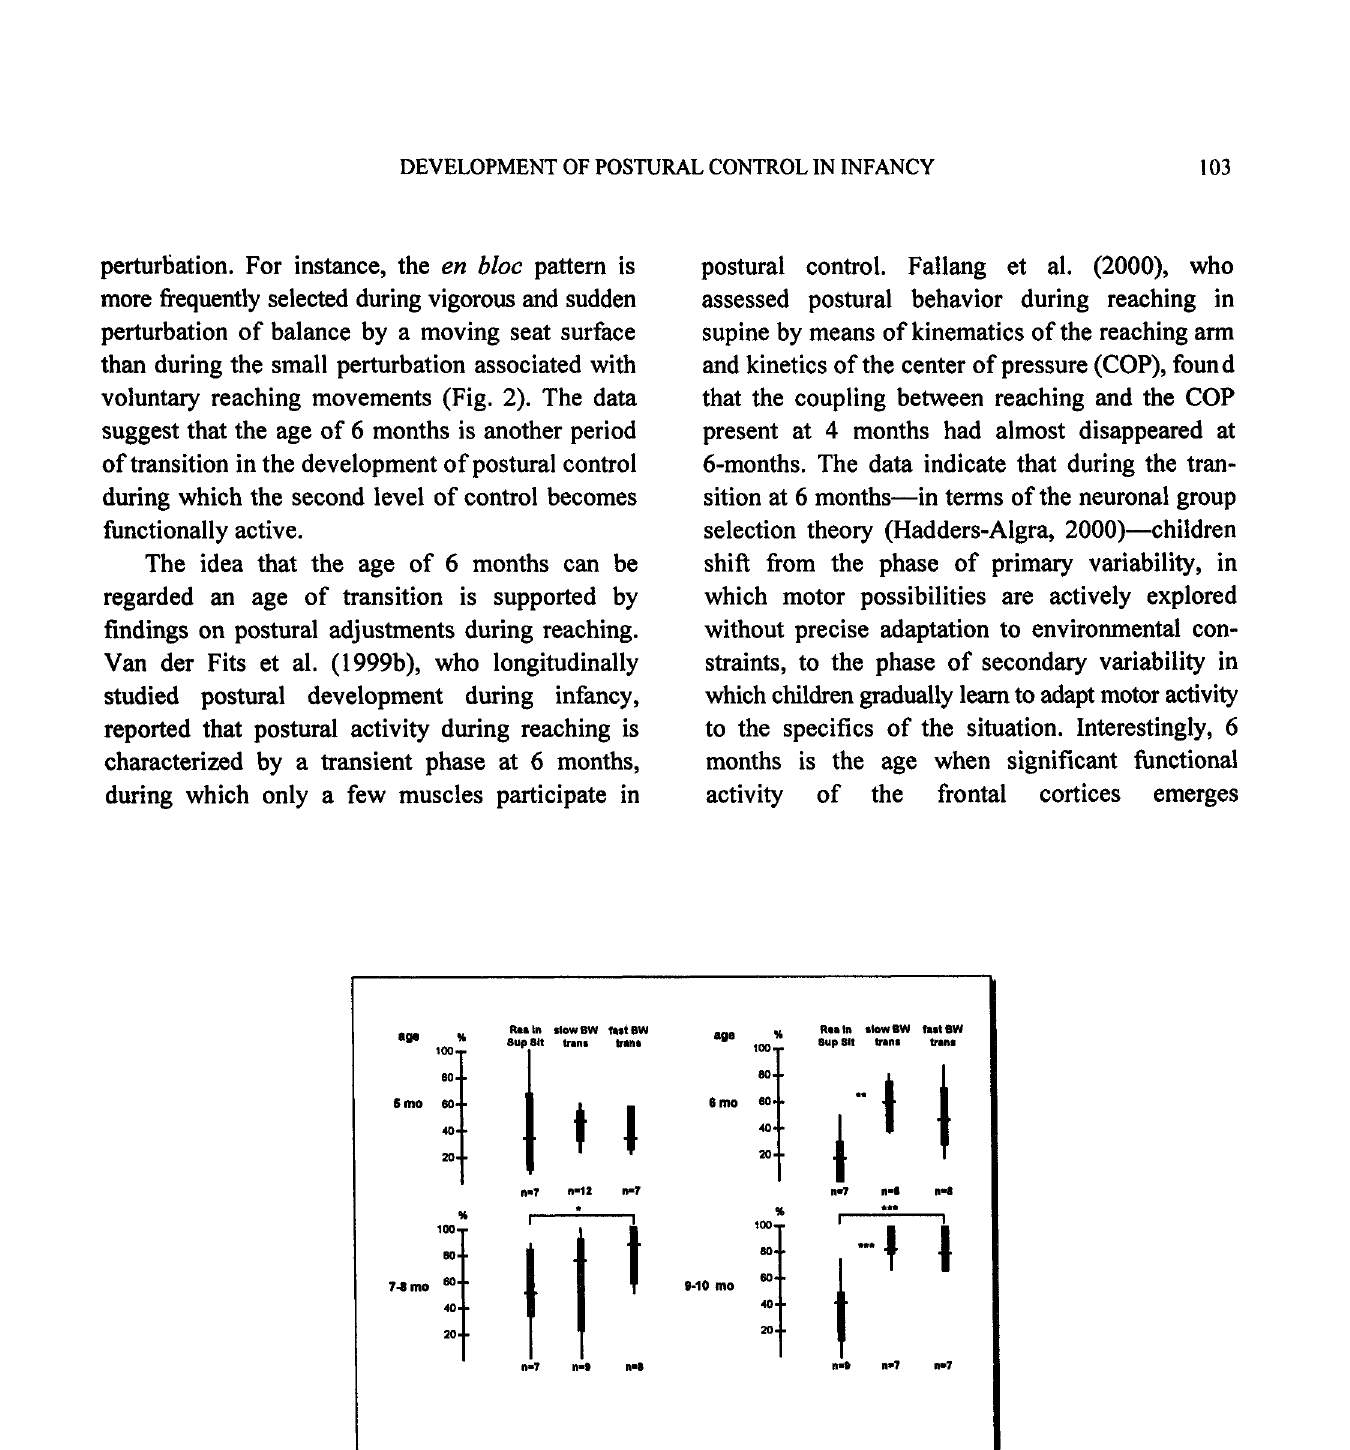
Fig. 2: Rates of occurrence of the direction specific ’NE + LE’ pattern in various conditions at various ages in typically developing infants. Note that the data are derived from two different studies. The data on postural activity during reaching in supported sitting (Rea in Sup Sit) are from the Van der Fits et al. study (1999b); the data on postural adjustments during backward translations (BW trans) are from the study ofHadders-Algra et al. study (1996a). The data are presented by ranges (vertical bars), interquartile ranges (boxes), and median values (horizontal bars). * p < 0.05, ** p < 0.01 (Mann Whitney test). Mo